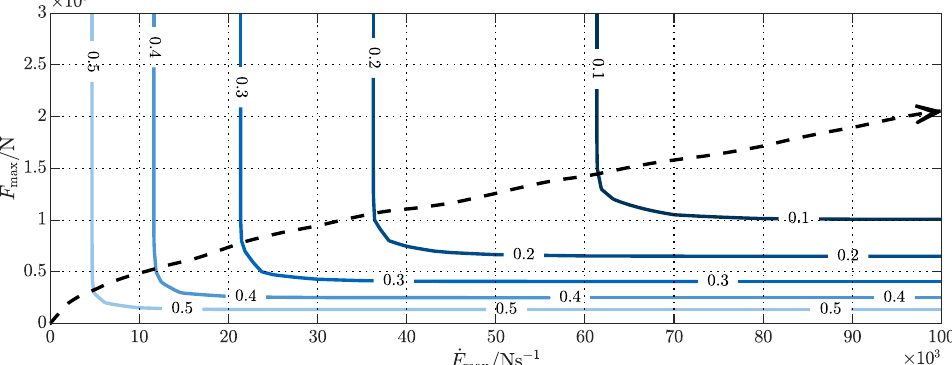
Figure 11. RMS body acceleration contour plot for the 90kmh − 1 AB profile